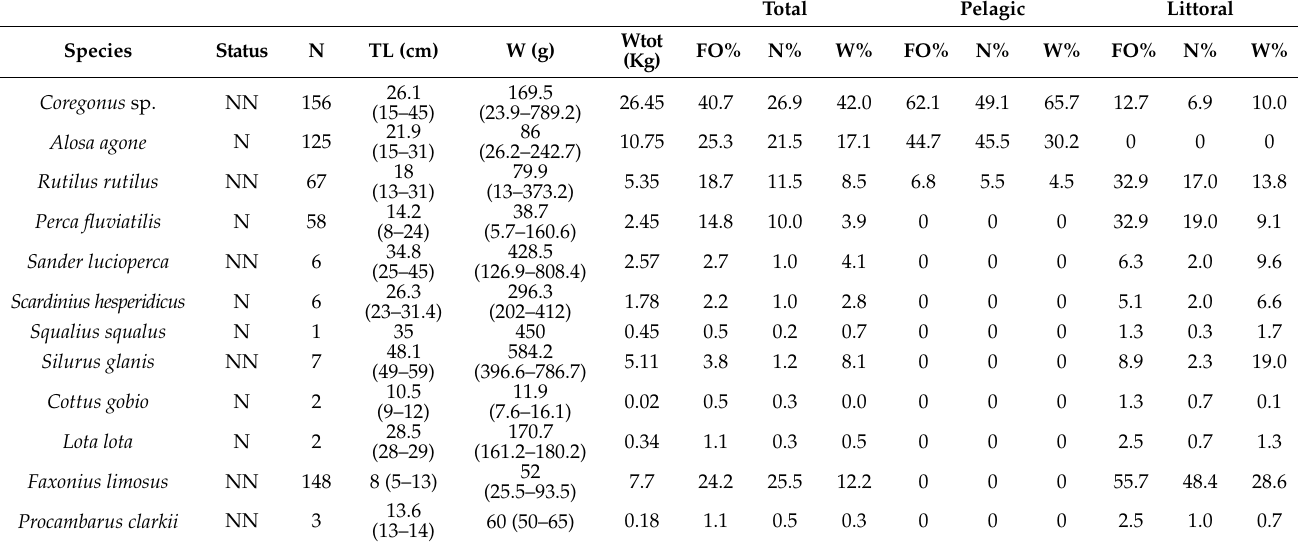
Table 3. List of the 12 prey species composing catfish diet and their relative frequency of occurrence (FO%) and numeric (N%) and biomass (W%) abundance in the total sample and for each habitat type. The native (N) vs. non-native (NN) status of species is also reported, together with the total number (N), mean total length (TL) in centimeters with min-max values in brackets, mean estimated weight in grams with min-max values in brackets, and total weight (Wtot) in kilograms for each prey found in the analyzed fish.